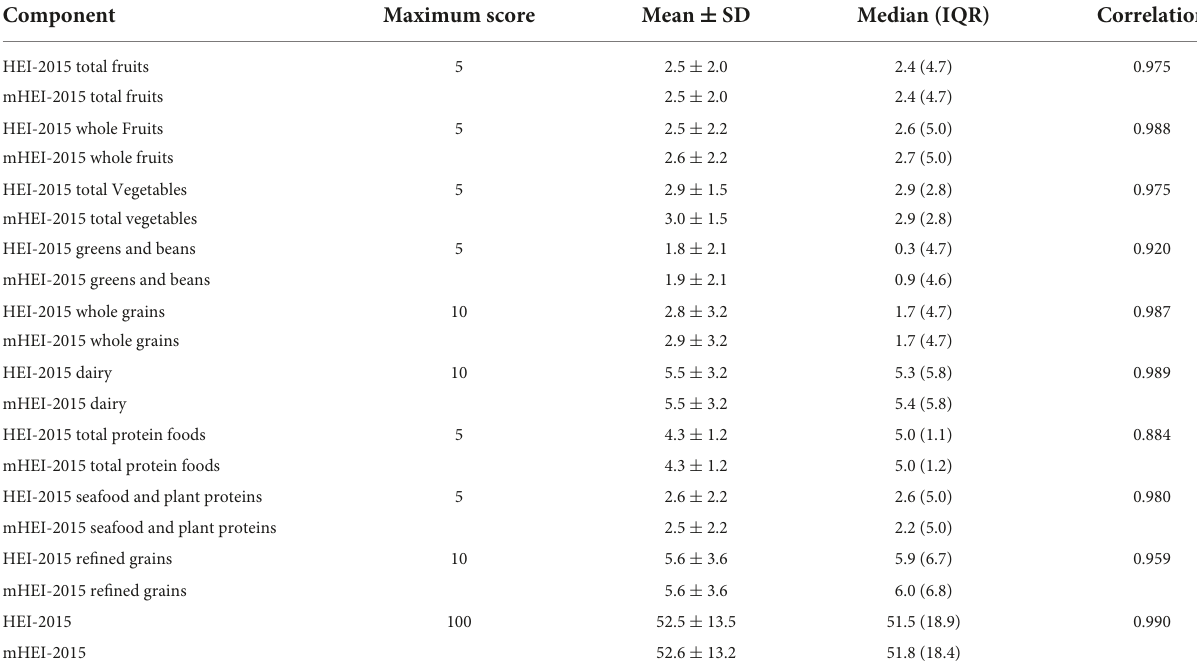
TABLE 3 Differences and associations of changed components and total index score of HEI-2015 and mHEI-2015 of the NHANES 2015-2016 ( n = 7,922).